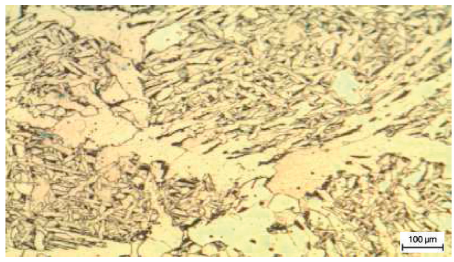
Figure 3: Microstructural analysis of WZ (100x).